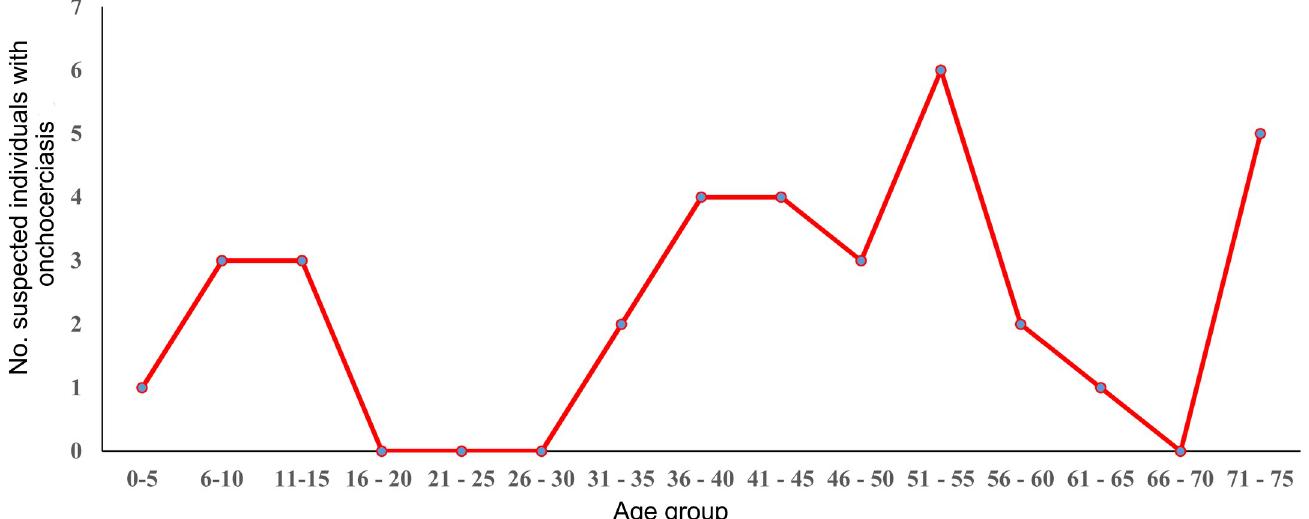
Fig 3. Suspected cases of onchocerciasis by age group in the formerly endemic focus of Southern Chiapas, Mexico, from 2016–2019.